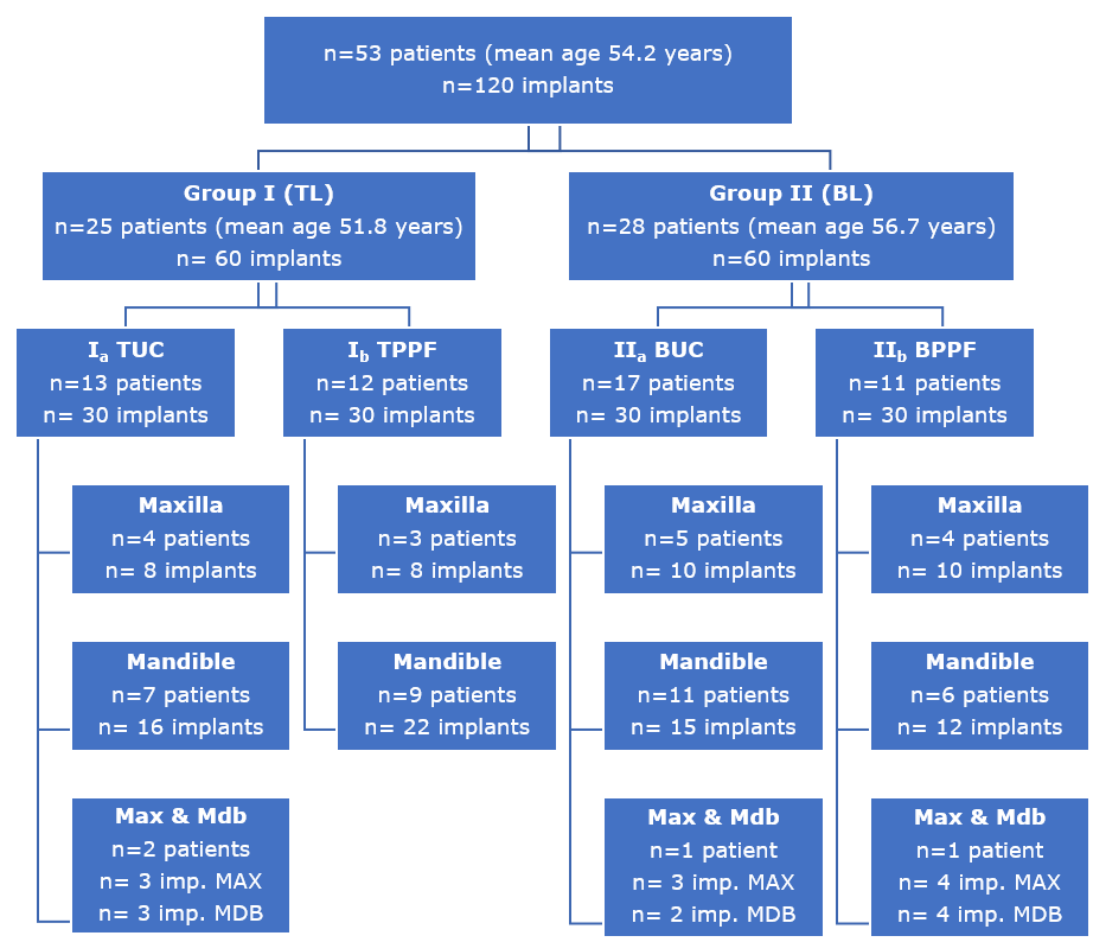
Figure 10. Distribution of the sample according to implant level and the type and location of the restoration.